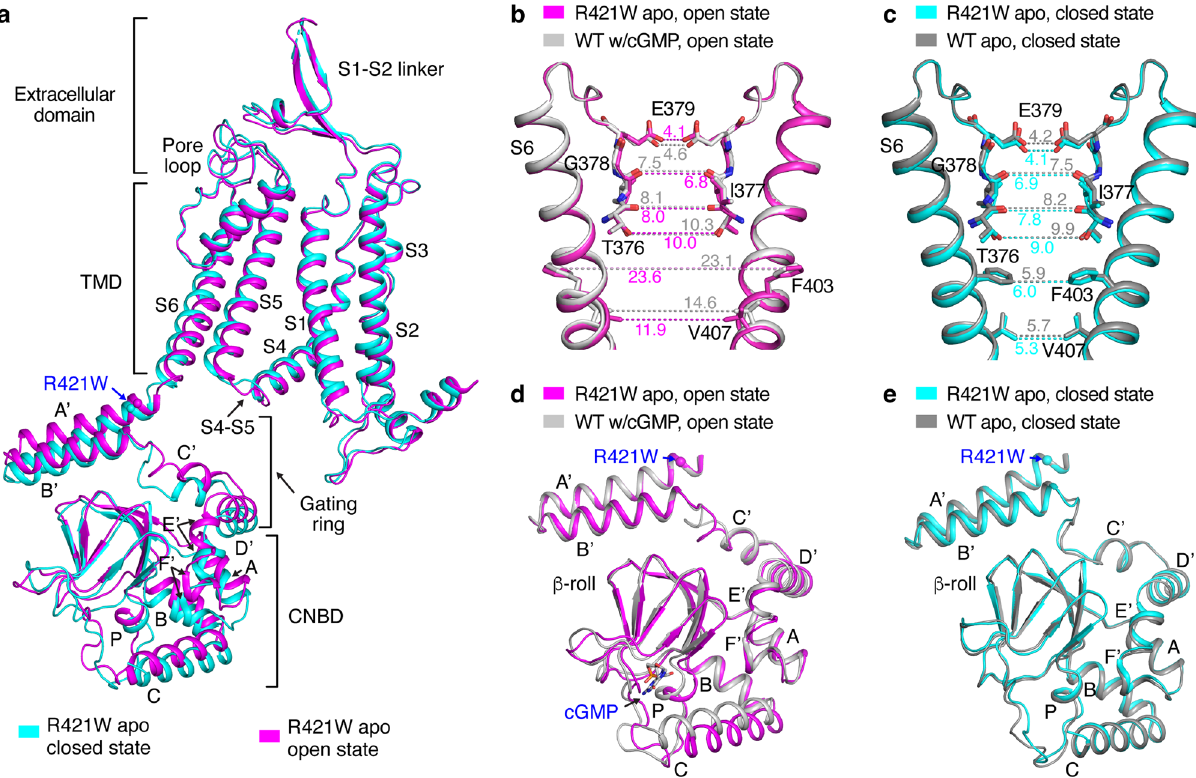
Fig. 3 Structures of apo TAX-4_R421W. a Superposition of protomer structures of the closed and open states of apo TAX-4_R421W. b Comparison of the SF and central cavity in the open states of apo TAX-4_R421W and cGMP-bound WT TAX-4 (PDB ID: 6WEK). c Comparison of the SF and central cavity in the closed states of apo TAX-4_R421W and apo WT TAX-4 (PDB ID: 6WEJ). d Comparison of the CNBD and C-linker in the open states of apo TAX- 4_R421W and cGMP-bound WT TAX-4. The C helix of apo WT TAX-4 is also shown. e Comparison of the CNBD and C-linker of the closed states of apo TAX-4_R421W and apo WT